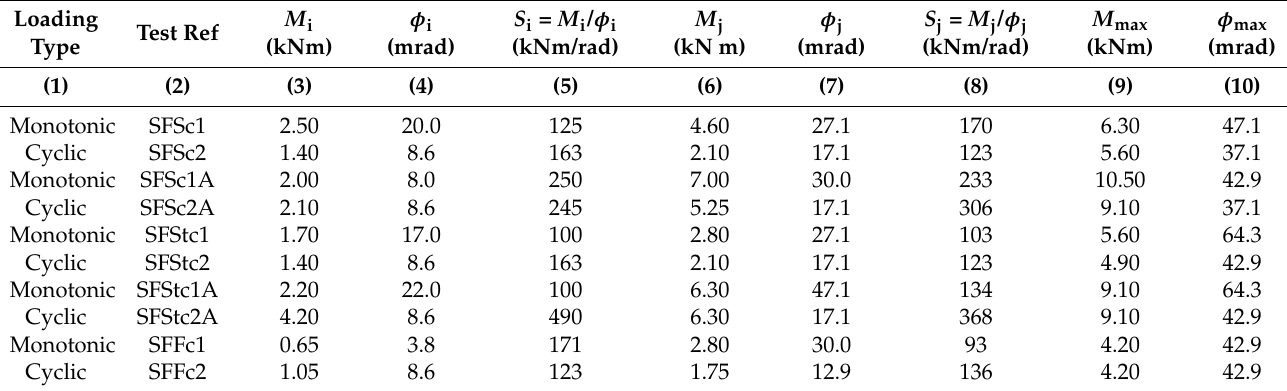
Table 4. Comparison of joint properties for monotonic and cyclic